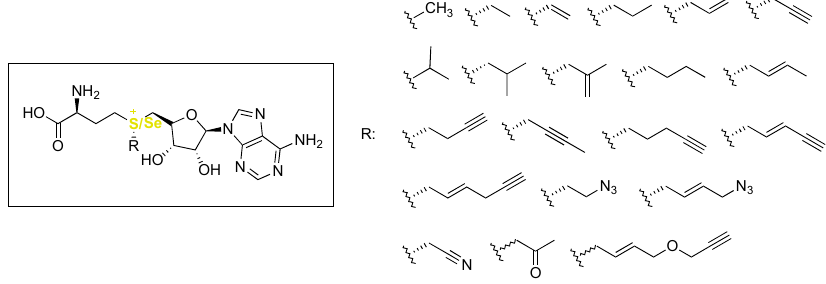
Figure 9. Library of SAM analogues used in biomolecular studies of SAM-dependent enzymes.